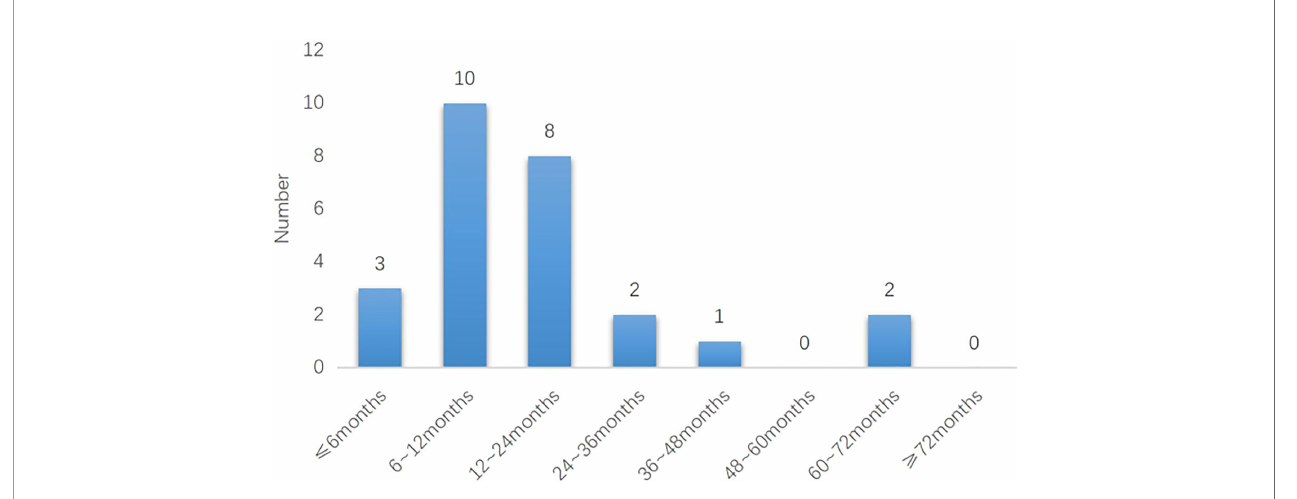
FIGURE 4 | The relationship between maintenance therapy and recurrence in different time periods in The Group 1 (n =